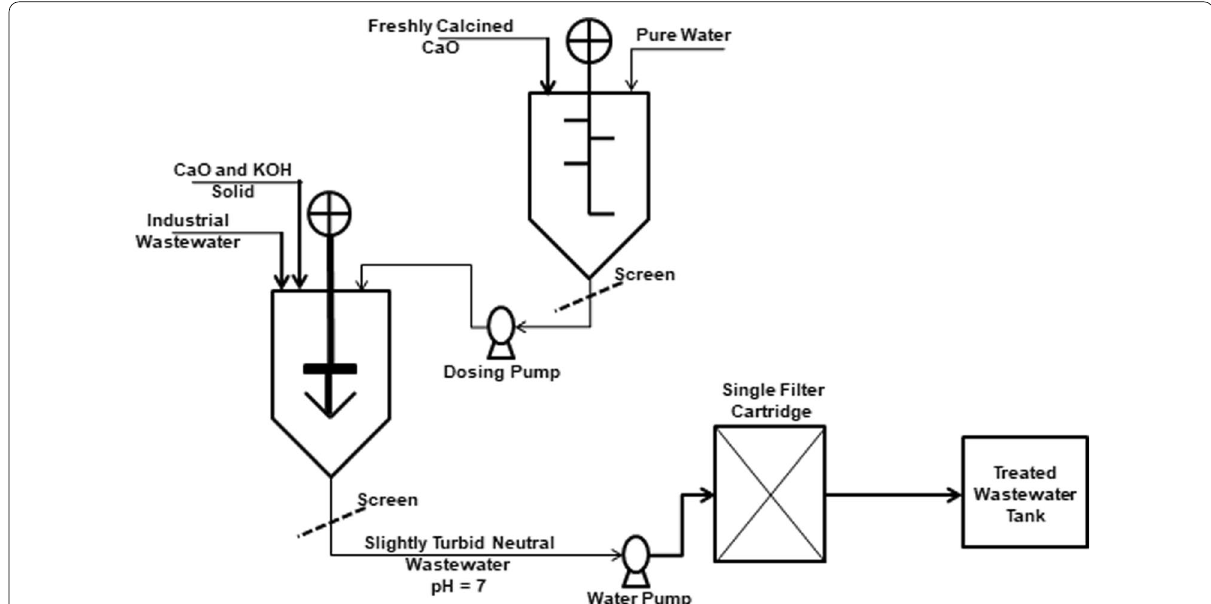
Fig. 3 Equipment flow sheet for industrial scale treatment